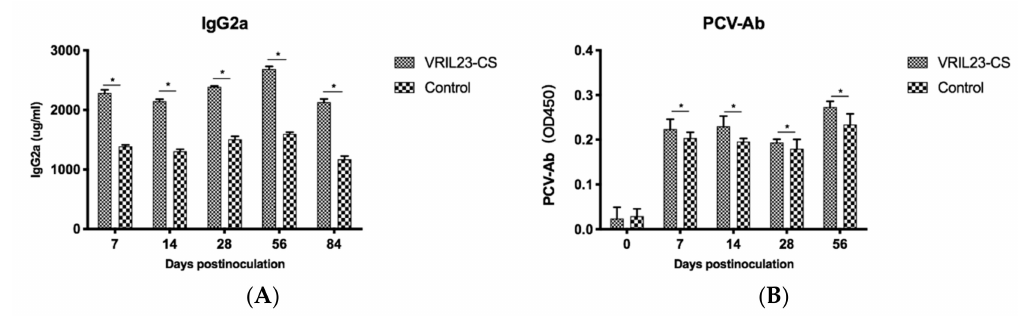
Figure 9. Changes of specific antibody and immunoglobulins in the sera of experimental pigs. ( A ) lgG2a; ( B ) PCV-Ab. * indicates the di ff erence between the two groups is significant, p < 0.05.